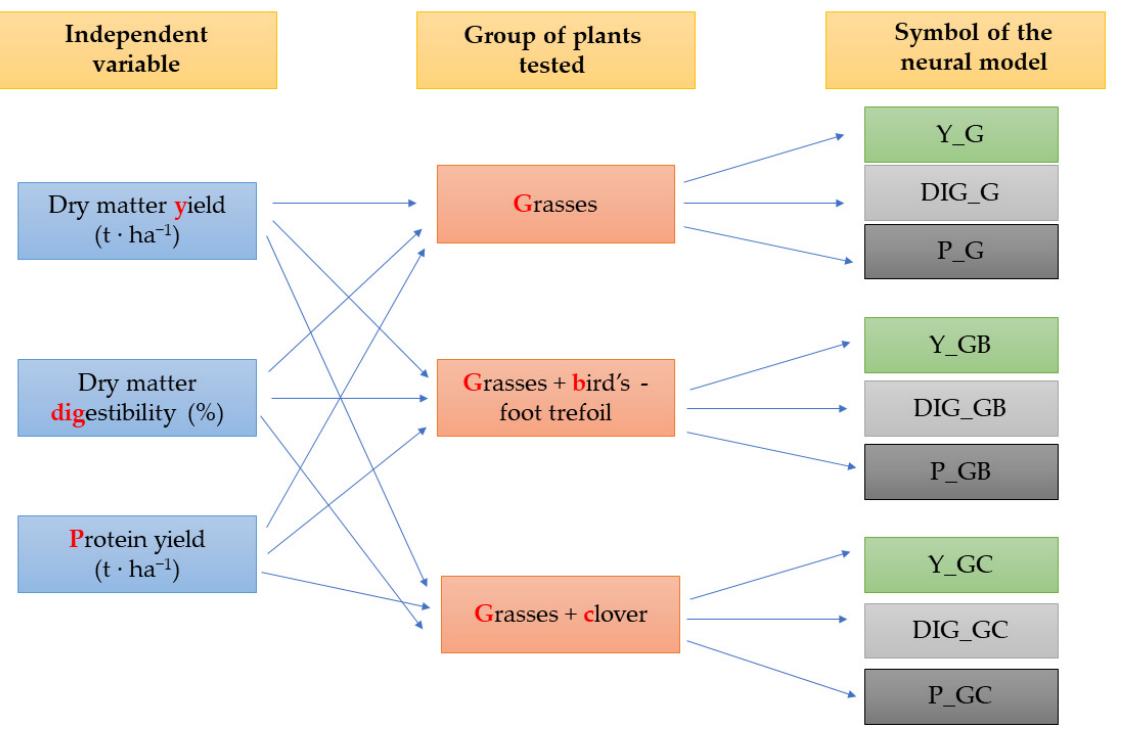
Figure 3. The deterministic models developed in the study, including the independent variables and three experimental variants.